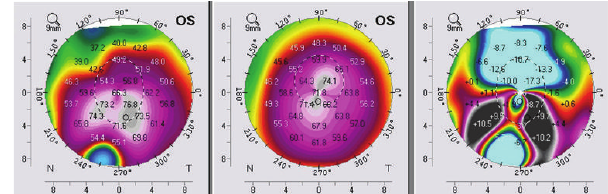
Figure8:Scheimpflugtomographybeforeandafterthemedicament